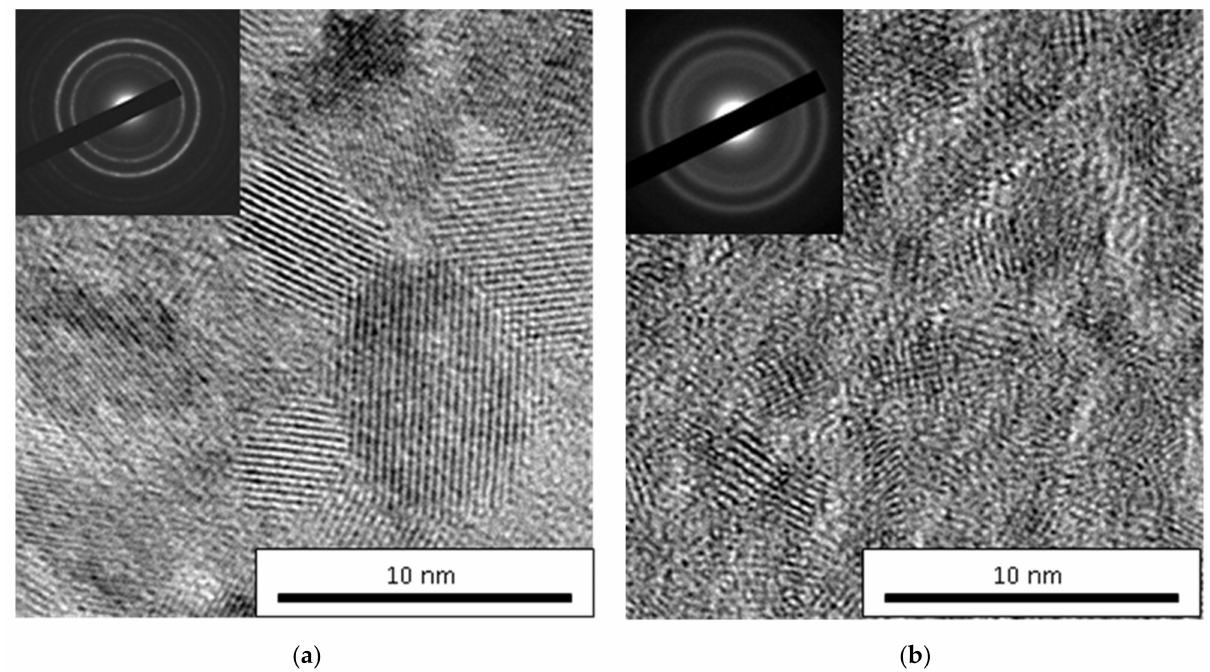
Figure 5. HR TEM images and SAED patterns of coatings 1 (100%Ar) ( a ) and 2 (85%Ar + 15%N 2 ) ( b